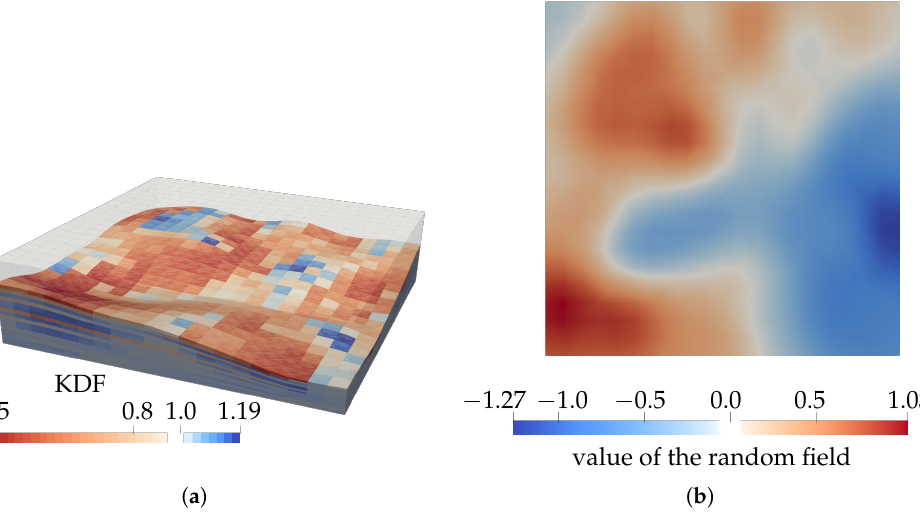
Figure 8. ( a ) KDF plot of deterministic analysis for R x loadcase; ( b ) random field example used for deterministic analysis.